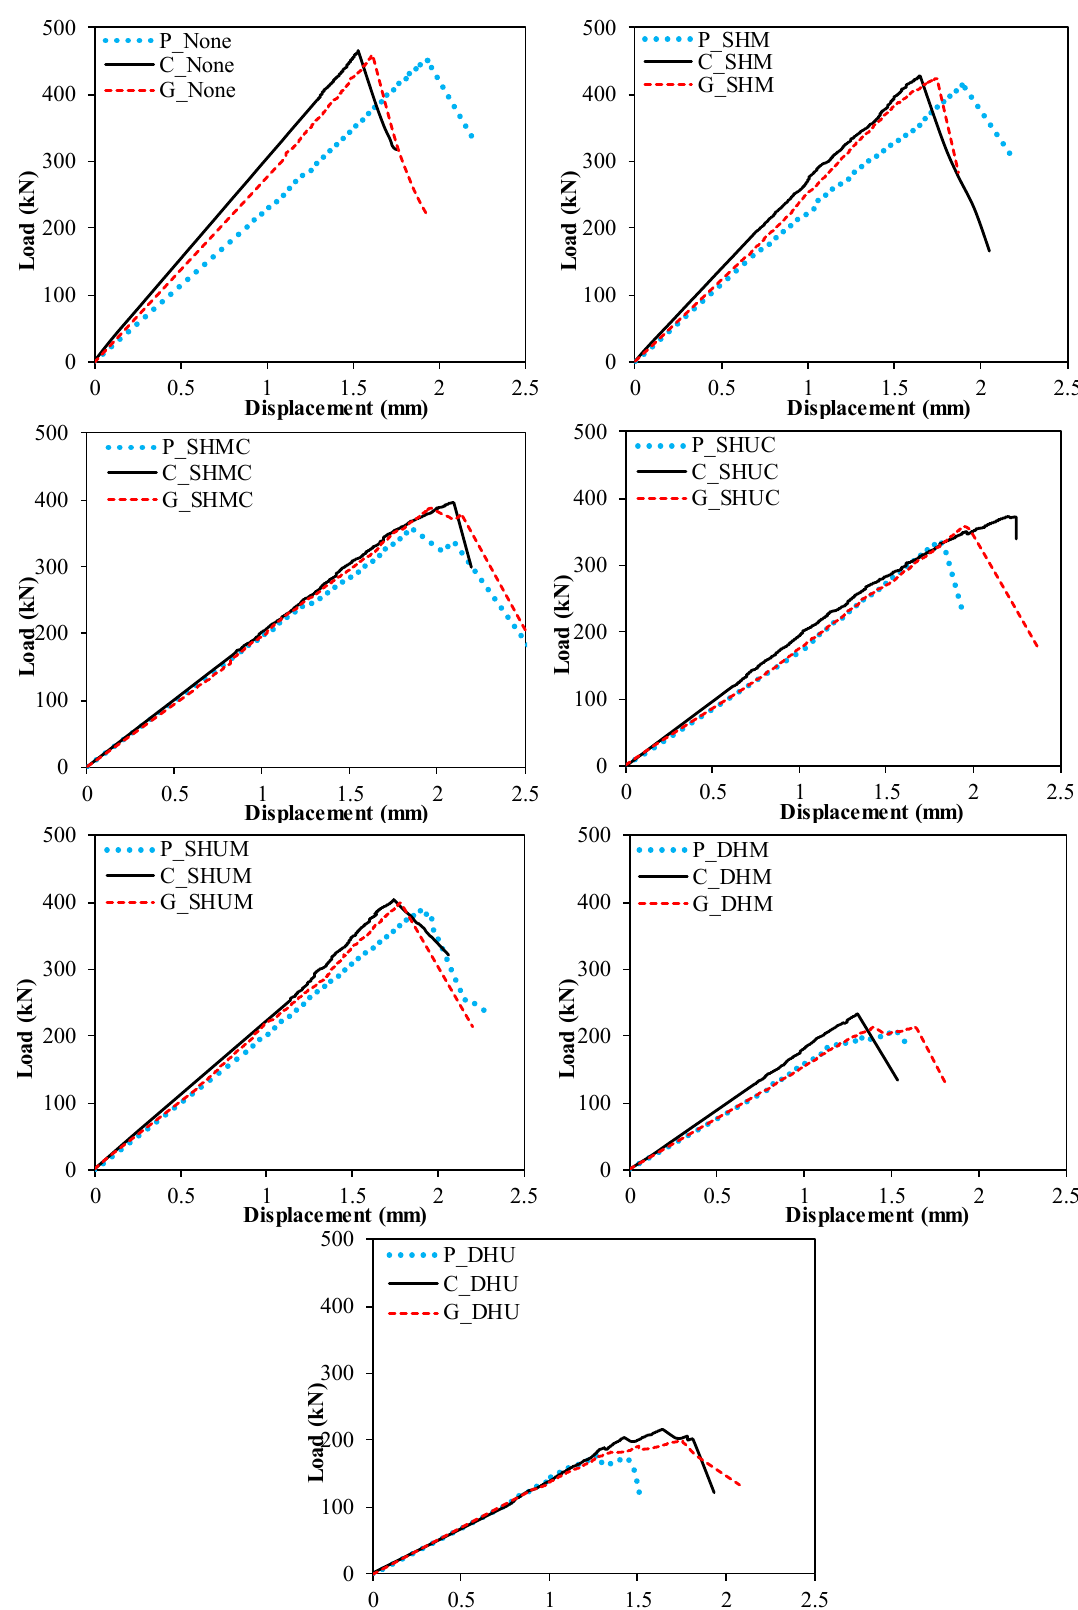
Figure 11. Effects of strengthening on different opening schemes.